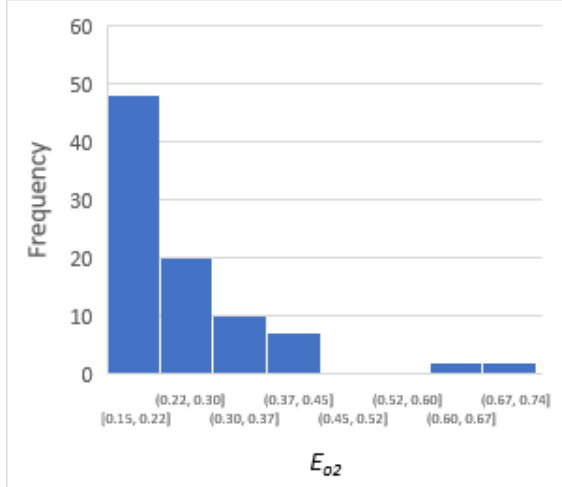
Figure 6. Distribution of 𝐸 𝑜2 .